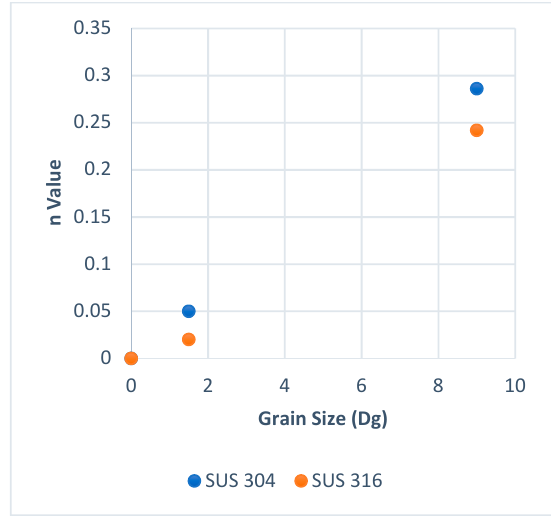
Figure 9. High work hardening at elevated temperature.